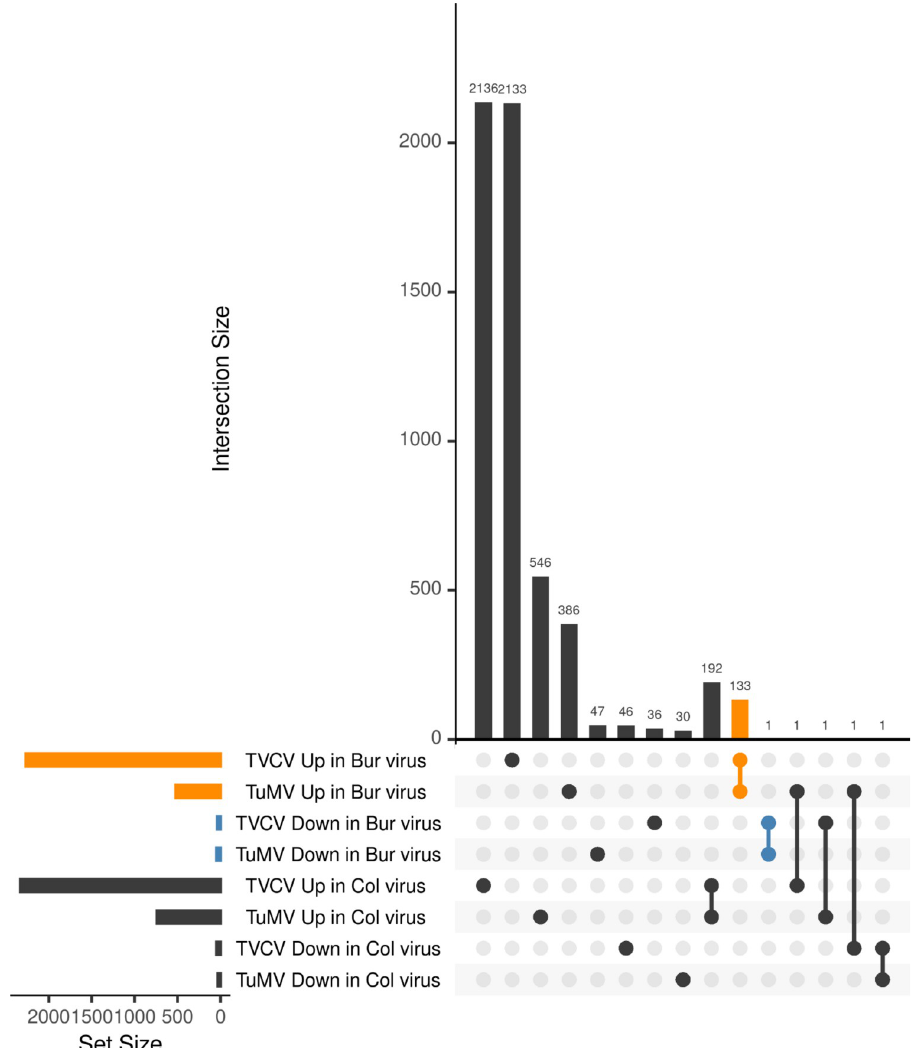
Fig 9. Commonly regulated sRNA sequences in TVCV and TuMV-infected plants. Sets of differentially expressed sRNA sequences (DES) in eight different conditions were compared and visualized using the UpSet R package. The vast majority of the DESs were specific to one condition (represented by single dots), while the number of common elements between the different conditions (connected dots) was much smaller. Blue color marks the sRNA sequences that are downregulated in Bur virus samples both in TVCV and TuMV-infected plants while orange color marks the sRNA sequences that are upregulated in Bur virus samples both in TVCV and TuMV-infected plants. Sets with zero elements are not